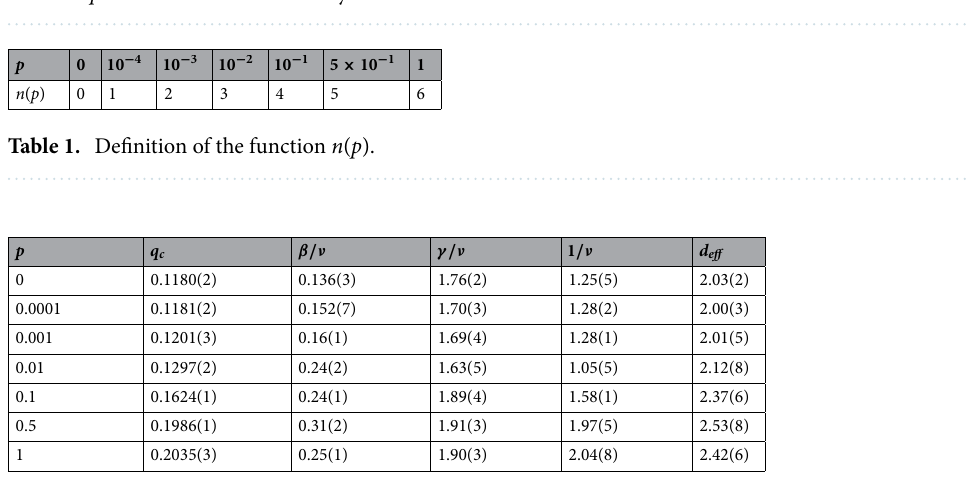
Figure 9. Plot of ( a ) the distance ln | q c ( L ) − q c | between the pseudocritical points and the critical point q c , ( b ) the magnitude of the magnetization ln M L , and ( c ) the magnetic susceptibility ln χ L as functions of the of ln L for different rewiring probabilities p . The slopes of ( a – c ) yield estimates for the critical exponents 1 /ν , β/ν , and γ/ν , respectively. The function n ( p ), defined in Table 1 is used to separate the curves corresponding to different values of p for the sake of visual clarity.